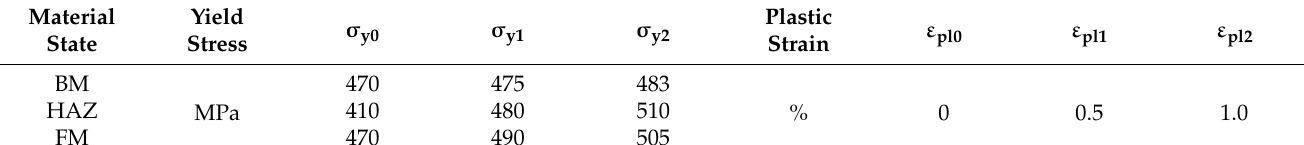
Table 2. Calibrated isotropic hardening parameters of the multilinear model. Material State